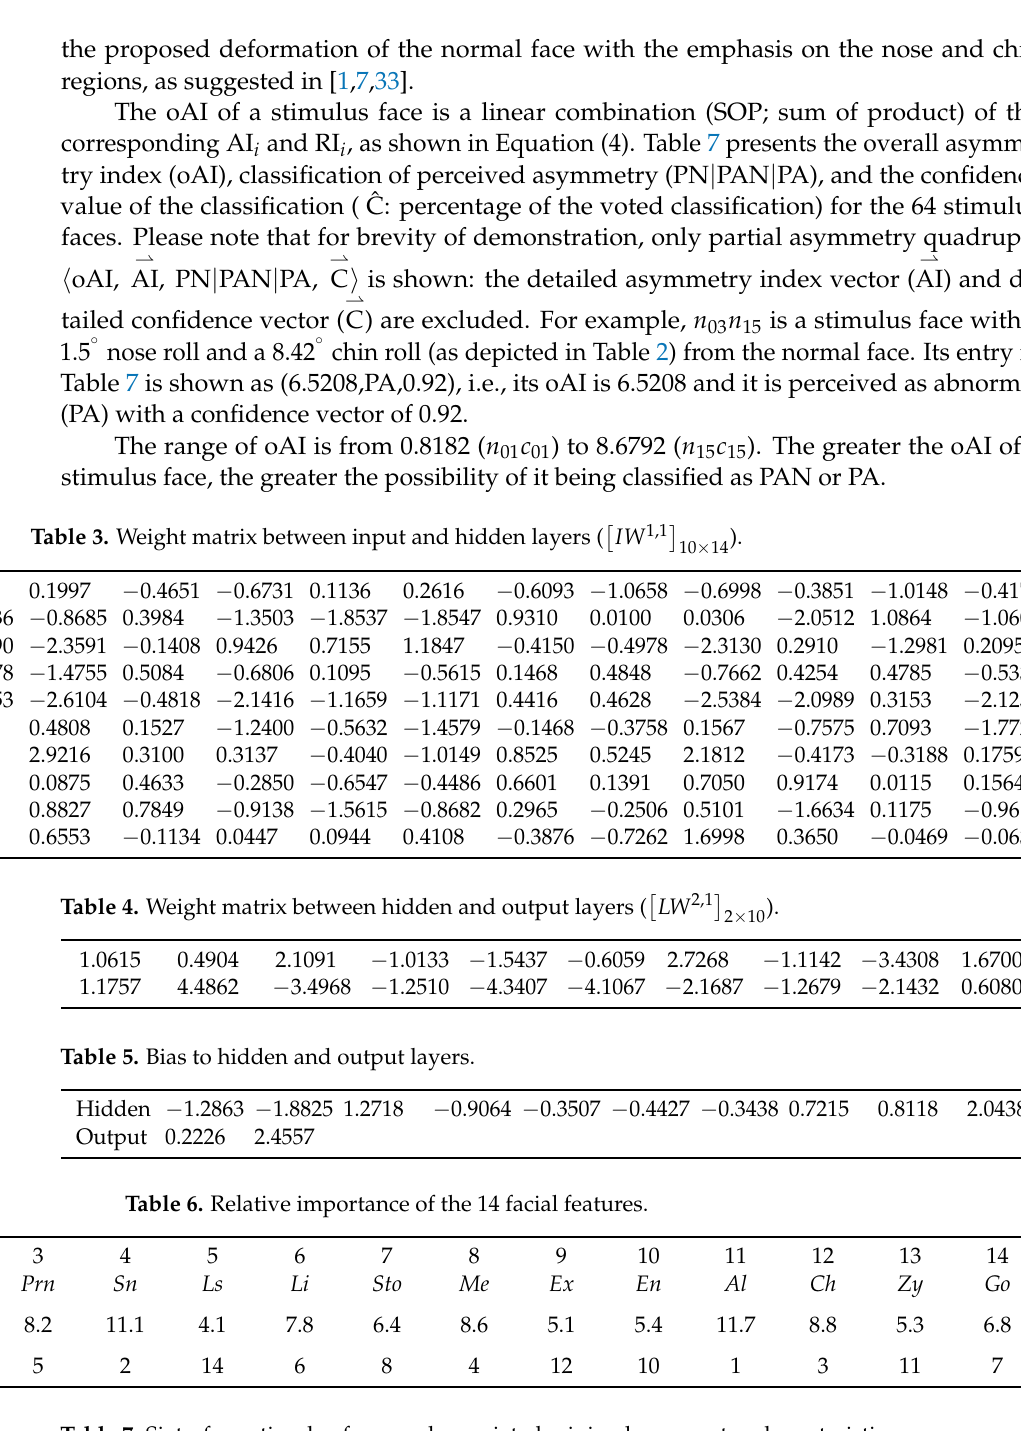
Table 7. Sixty-four stimulus faces and associated minimal asymmetry